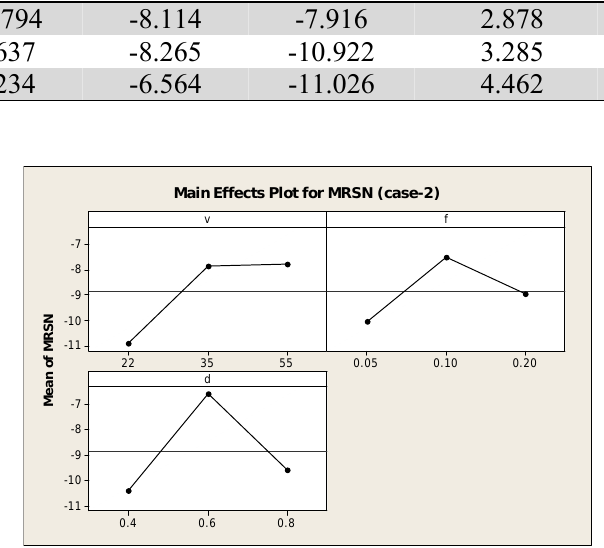
Mean multi-response S/N table for case-1 (w 1 = 7, w2 = 3) Symbol Process parameter